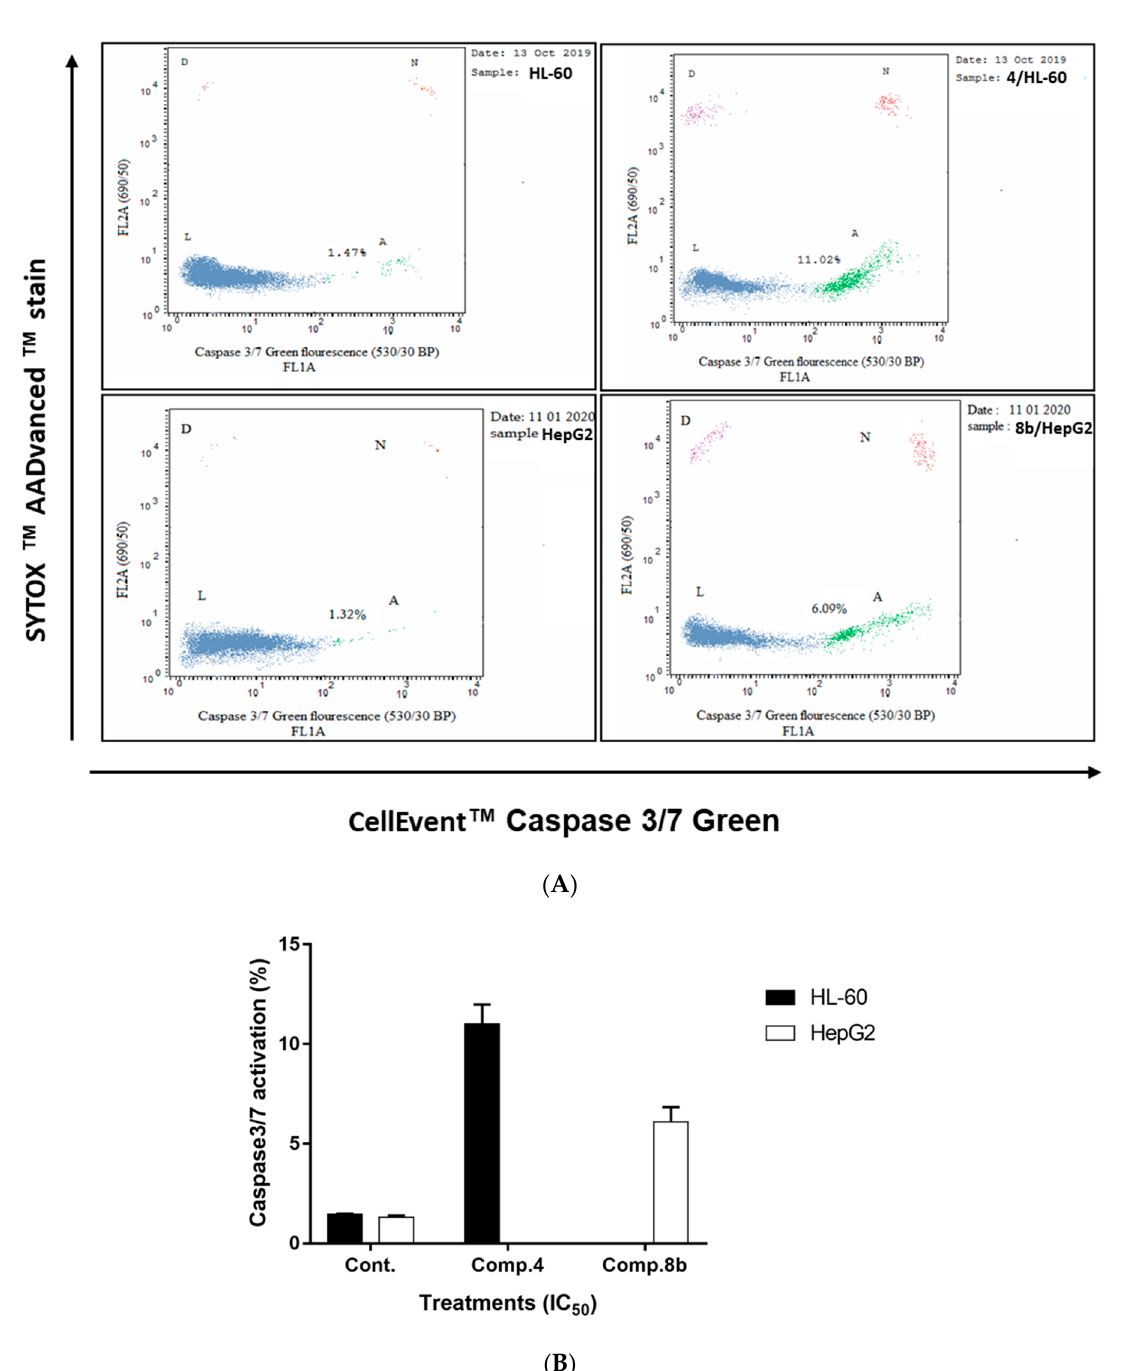
Figure 4. ( A ) Caspase inhibitory activity in cancer HL60 and HepG2 cells was treated with compounds ( 4 ) and ( 8b ), respectively, for 48 h, using the “CellEvent ® Caspase 3/7 Green Flow Cytometry kit”, where “ L , viable cells; A , apoptotic cells; N , necrotic cells; and D , dead cells”. ( B ) Graphical presentation of a comparison of apoptotic cancer cells due to active caspases 3/7 of the tested compounds. The data are expressed as the mean ± SEM of three independent experiments in triplicate. Gene Expression Analysis for the Apoptosis-Related Genes Both intrinsic and extrinsic genes (P53, Bax, Caspase 3, Caspase 7, PI3k, AKT, and Bcl-2) controlling apoptosis were screened for their relative mRNA expression using RT-PCR analysis to investigate the apoptosis-inducing pathway of the cytotoxic compound ( 4